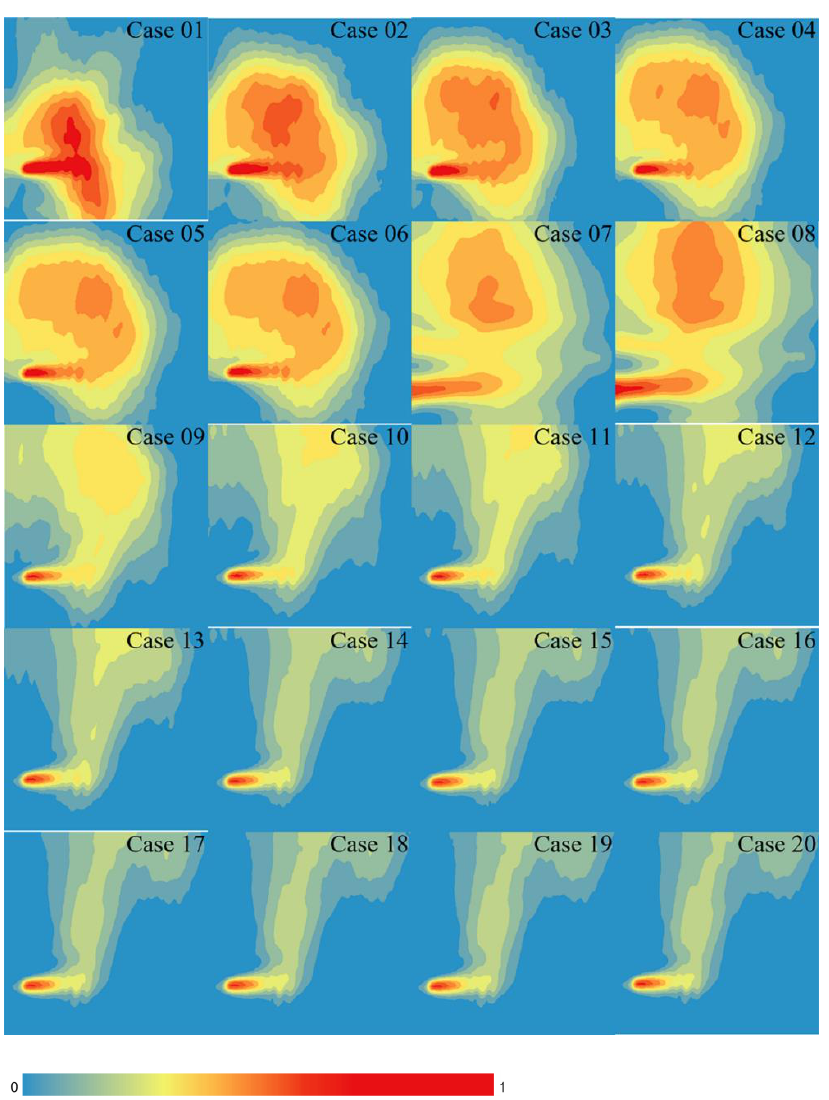
Figure 7. The normalized concentration fields on the central plane under different conditions obtained by the CNN model.